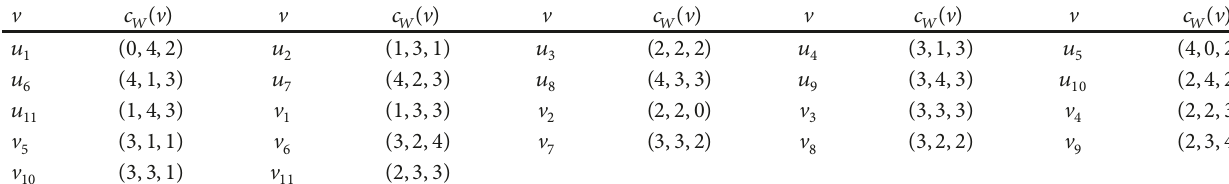
Table 3: The code 𝑐 𝑊 ( V ) of V with respect to 𝑊 = {𝑢 1 , 𝑢 5 , V 2 } in 𝑃(11,3) .